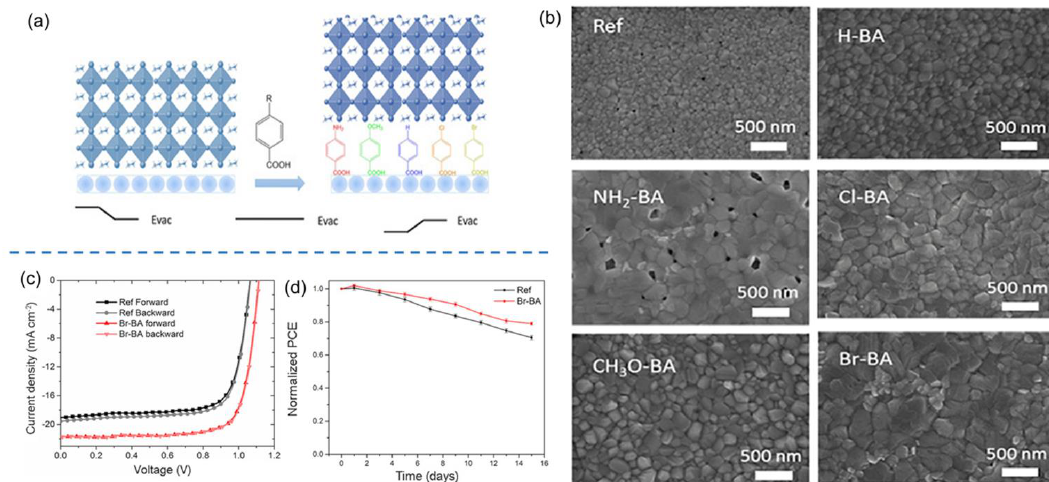
Figure 4. ( a ) Schematic diagram of NiO x /MAPbI 3 interface as modified by various BA − based SAMs; ( b ) top − view SEM images of perovskite films deposited on the NiO x HTLs without and with modification by various BA − based SAMs; ( c ) J – V curves of PSCs with the pristine NiO x and Br − BA modified NiO x as HTLs under forward and reverse scan directions; ( d ) stability tests of PSCs with the pristine NiO x and Br − BA modified NiO x as HTLs in ambient conditions with an RH of 30%. Reproduced from [120], with permission from the ChemSusChem, 2017.